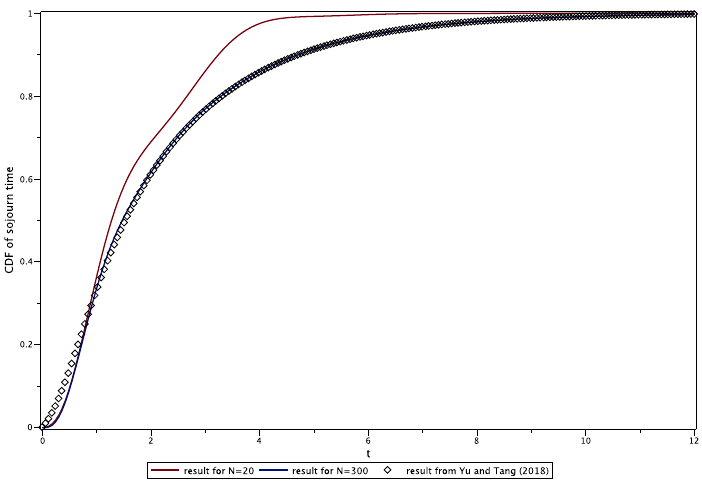
Figure 4. Comparison among the CDF of the sojourn times for different values of N from Example 4 of Yu and Tang